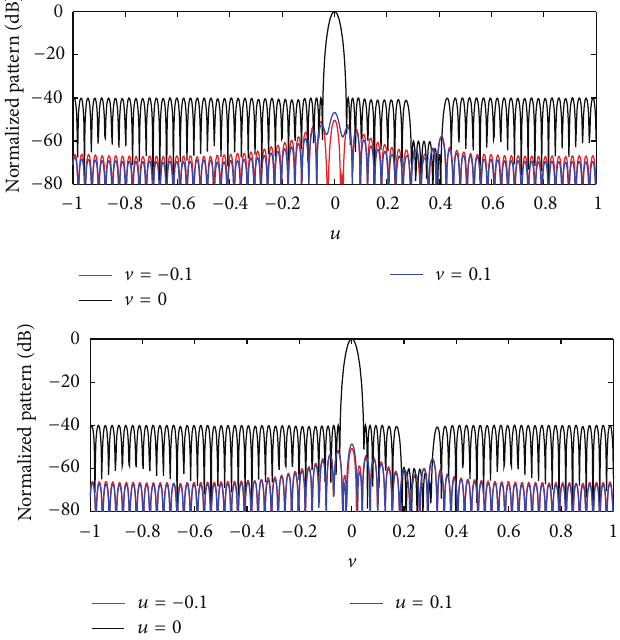
Figure 9: Normalized pattern at 𝑢 -cut and V -cut